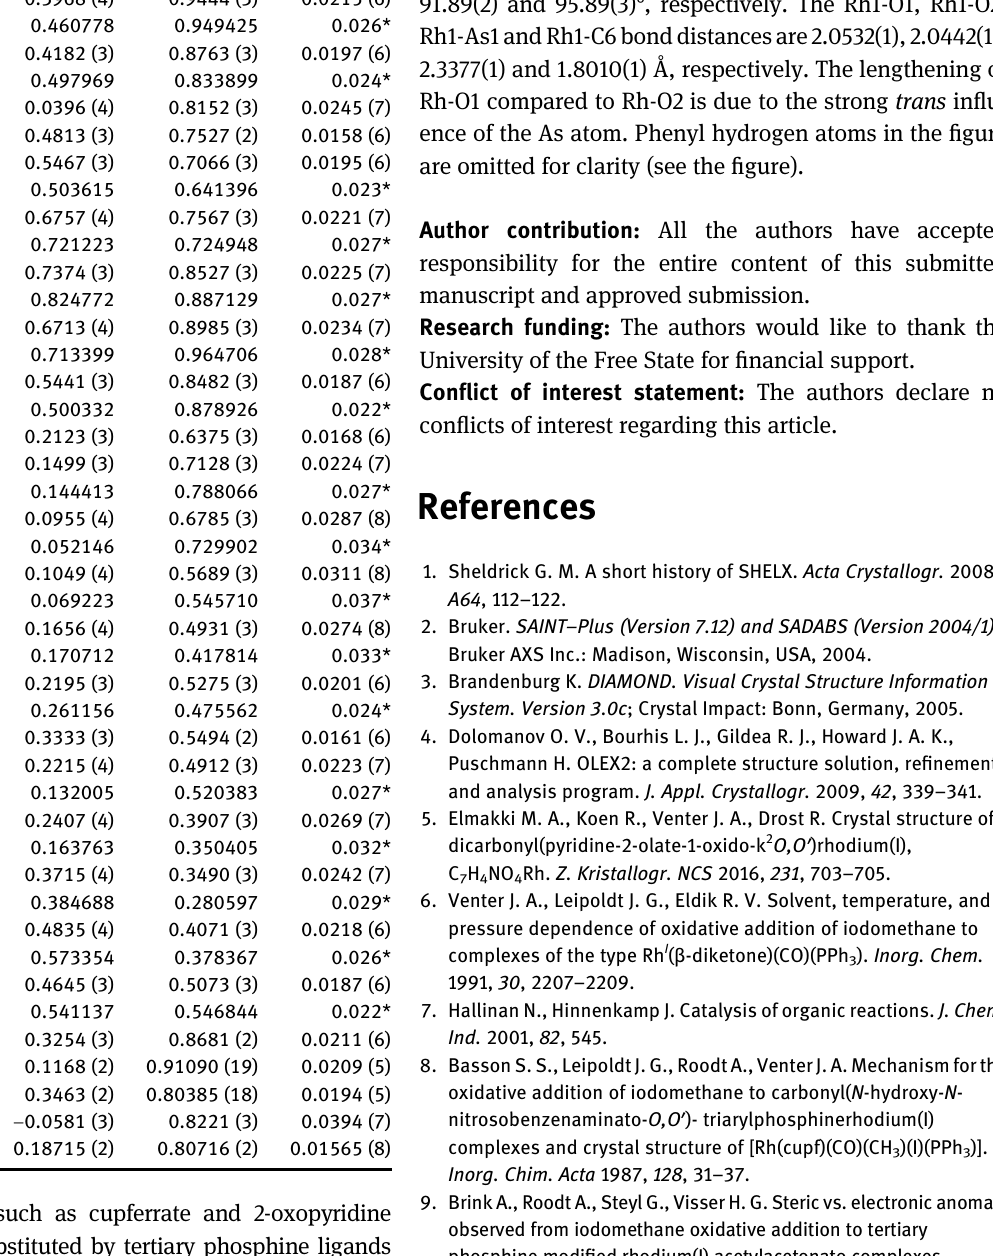
application in catalytic hydroformylation, hydrogenation, carbonylation, and decarbonylation [6 – 13]. The coordination mode in the title complex is similar to the complexes reported previously [14, 15]. In this structure, the ligands are coordinated to rhodium in a distorted square planar geometry. This distortion of the O1-Rh-O2 bond angle from 90 ° is indicated by the small bite angle of 79.87(2) ° of the fi ve membered ring as well as the As1-Rh1-C6, As1-Rh1-O2 and C6-Rh1-O1, angles of 92.37(2), 91.89(2) and 95.89(3) ° , respectively. The Rh1-O1, Rh1-O2, Rh1-As1 and Rh1-C6 bond distances are 2.0532(1), 2.0442(1), 2.3377(1) and 1.8010(1) Å, respectively. The lengthening of Rh-O1 compared to Rh-O2 is due to the strong trans in fl u- ence of the As atom. Phenyl hydrogen atoms in the fi gure are omitted for clarity (see the fi gure).